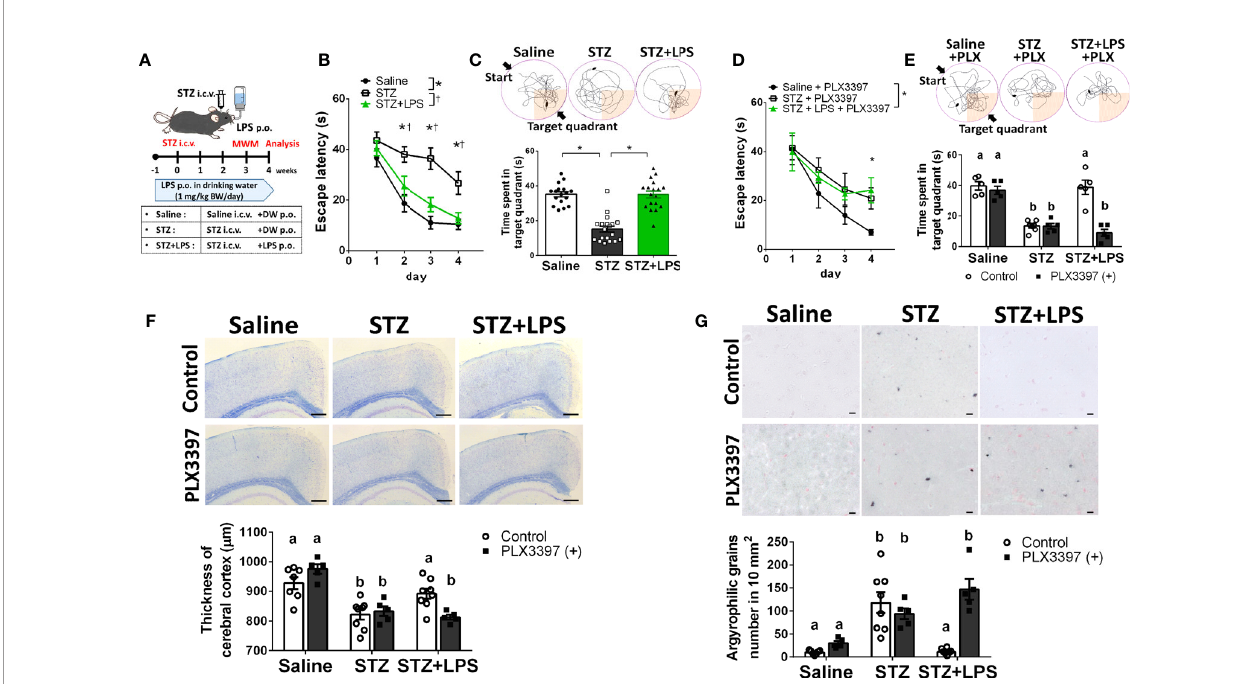
FIGURE 1 | Microglia are indispensable for preventing diabetes-related cognitive dysfunction (DRCD) through oral administration of LPS (OAL). (A) The experimental schedule of DRCD and OAL. (B, C) Prevention of deterioration of the learning ability and memory performance induced by OAL (n = 17 – 19). (D, E) PLX3397 reversed the prevention of DRCD by OAL (n = 5 – 7). (F) Prevention of cerebral cortex atrophy by OAL (n = 5 – 8). Bars, 200 m m. (G) Prevention of accumulation of argyrophilic grains by OAL (n = 5 – 8). Bars, 10 m m. Means ± SE are presented. * , † p or a,b p < 0.05 for one-way ANOVA with Tukey ’ s multiple comparisons or two- way ANOVA with Sidak multiple comparisons. DW, distilled water; i.c.v., intracerebroventricular; p.o., per